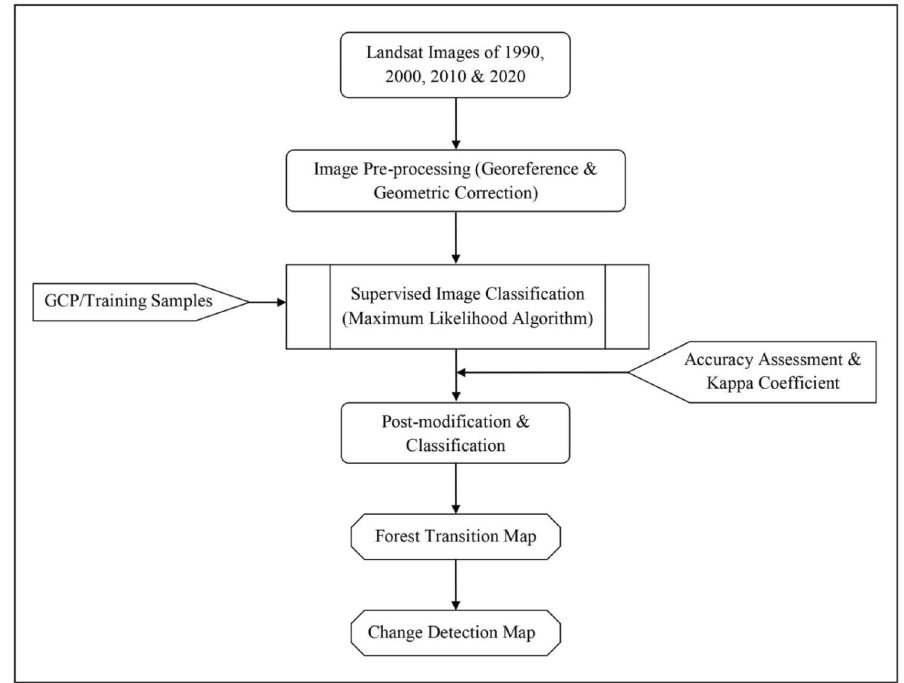
Figure 2. Methodology followed in the study.